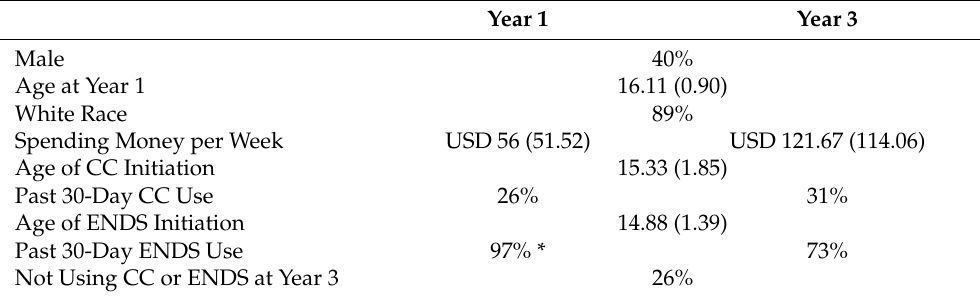
Table 1. Participant ( n = 35) characteristics (with standard deviations).